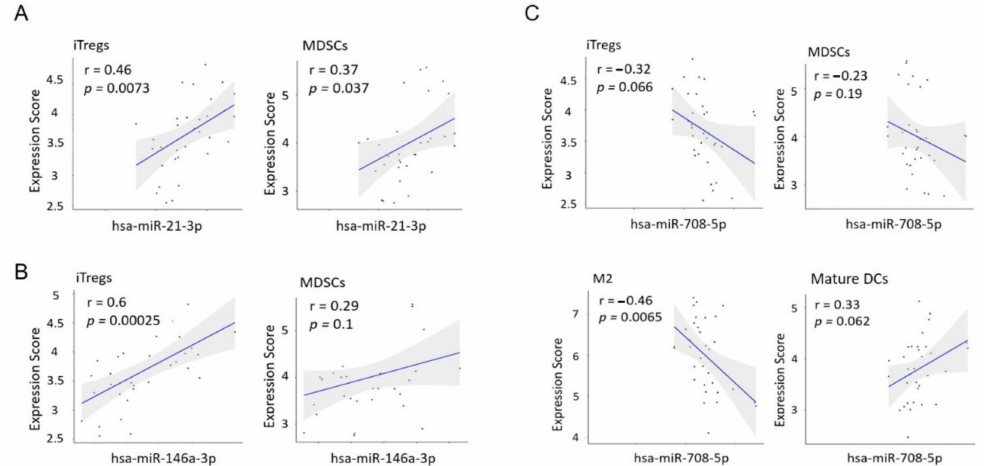
Figure 6. The correlation analysis of miR expression and the immune cell gene score in MF-LCT. ( A ) Correlation analysis of miR-21-3p with iTregs and MDSCs in MF-LCT. ( B ) Correlation analysis of miR-146a-3p with iTregs and MDSCs in MF-LCT. ( C ) Correlation analysis of miR-708-5p with iTregs, MDSCs, TAM (M2) and immature DCs in MF-LCT. Pearson’s correlation